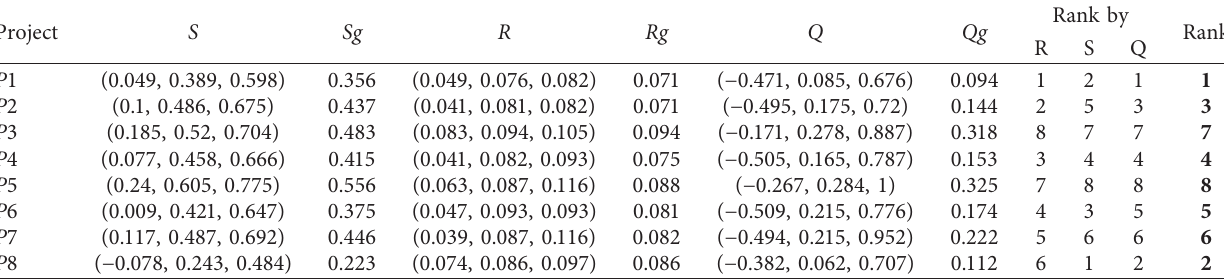
Table 44: Project ranking in fuzzy condition.